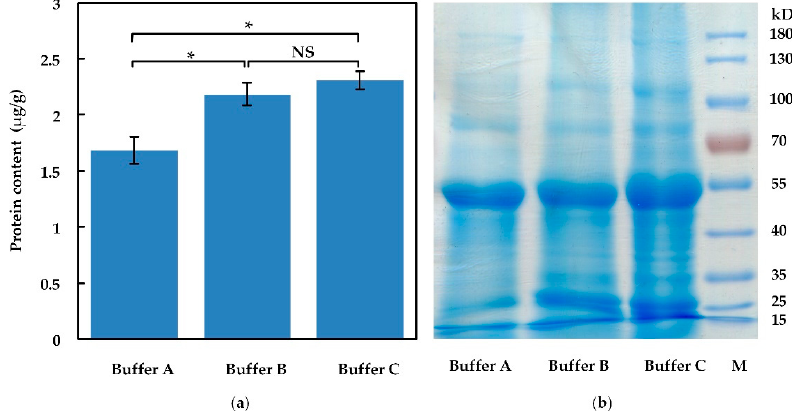
Figure 1. Total-protein (including peptides) extracted in different lysate buffers. ( a ) Total-protein yields extracted in different lysate buffers; ( b ) total-protein was visualized in SDS-PAGE. Asterisk (*) represents significant difference ( P < 0.05). NS represents no significant difference. Error bar represents the mean ± standard deviation ( n = 3).